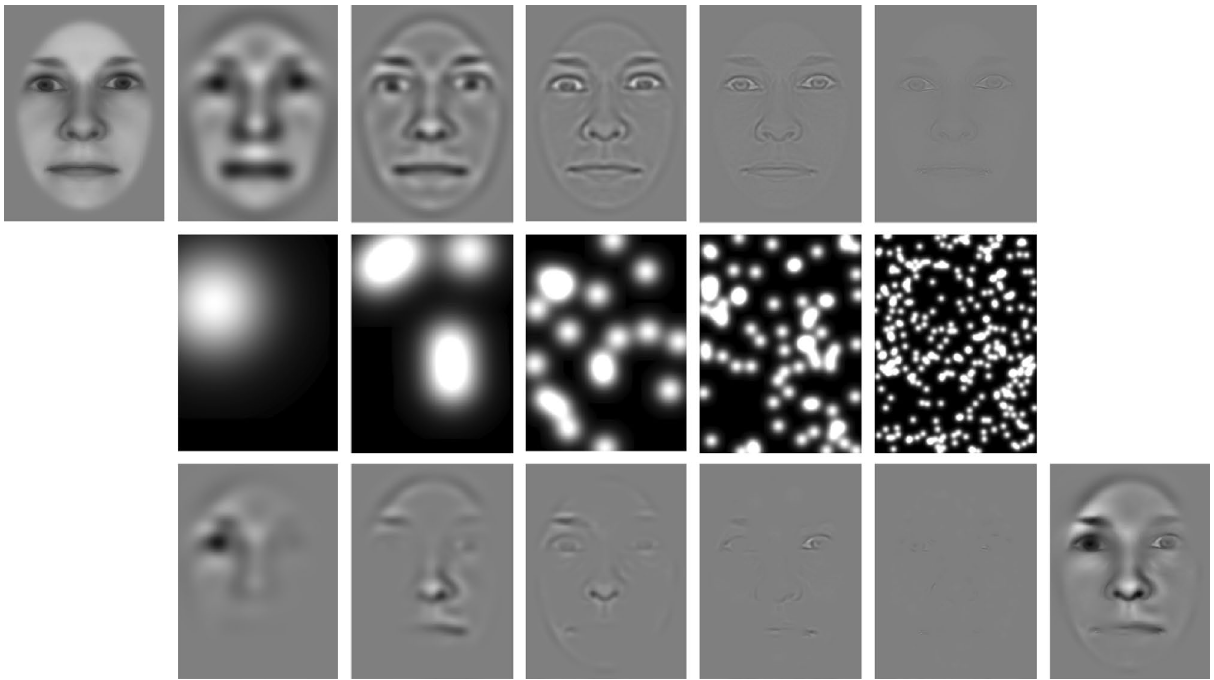
Figure 1. Illustration of our adaptation of the bubble technique 65 . The top row shows the spatial frequency decomposition of a single (i.e., the leftmost) image. The middle row depicts randomly placed Gaussian blobs for each spatial scale. The total surface covered by all blobs is kept constant. The bottom row shows the decomposed faces, masked by the corresponding blobs. The final (i.e., the rightmost) image shows a stimulus example, which contains the sum of all images depicted in the bottom row. Please note that all face images shown in this publicatin do not belong to the actual stimulus set. For purposes of copyright protection we used an artificially created face (generated using the software FaceGen 3D Print Home 2.0) here and as a background image for all classification maps (Figs. 4, 6, 8,